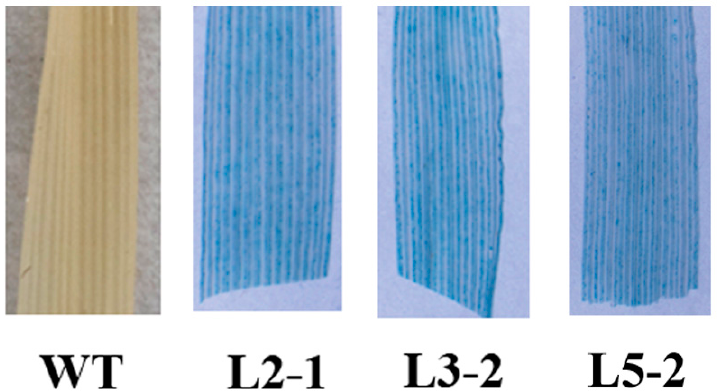
Figure 1. Confirmation of Arabidopsis senescence associated gene 101 ( AtSAG101 ) in transgenic Brachypodium distachyon . Histochemical staining of the β -glucuronidase (GUS) gene in AtSAG101 transgenic B. distachyon . WT, wild type plants; L2-1, L3-2 and 5-2, transgenic B. distachyon plants.